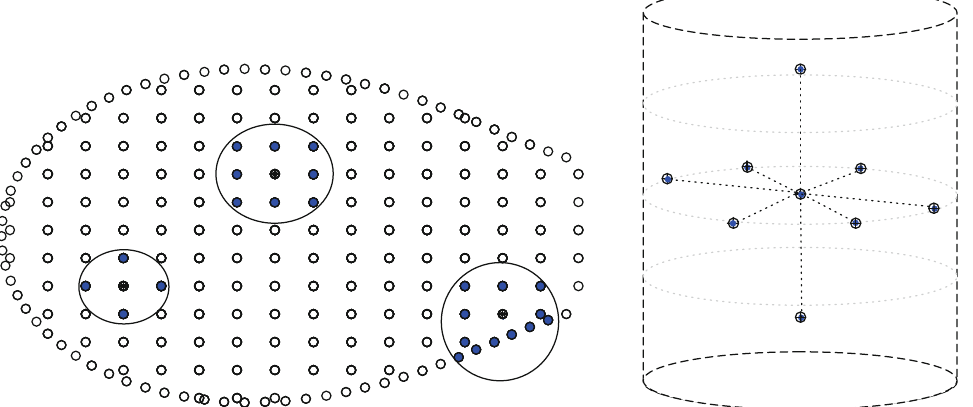
Figure 3: Schematic showing fi ve-node, nine-node, and thirteen-node local domains Ω